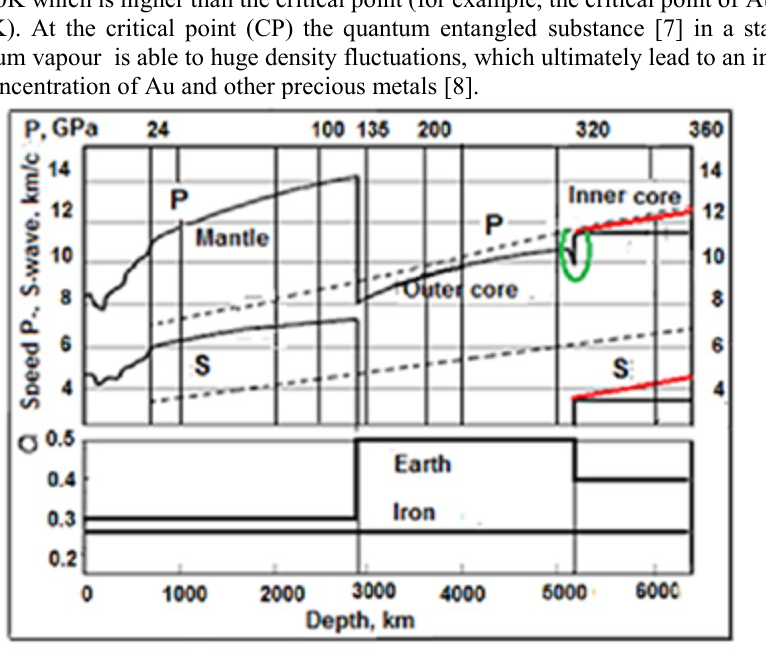
Fig. 2 . The velocities of P- and S-waves in the Earth's shells and, in particular, in the G-core and in iron (dashed line) at the external pressure equal to that of the Earth’s one. Poisson's coefficients ϭ of Earth and iron